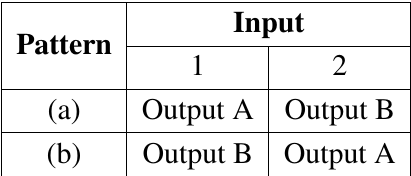
Table 1. Connecting pattern of inside power router.